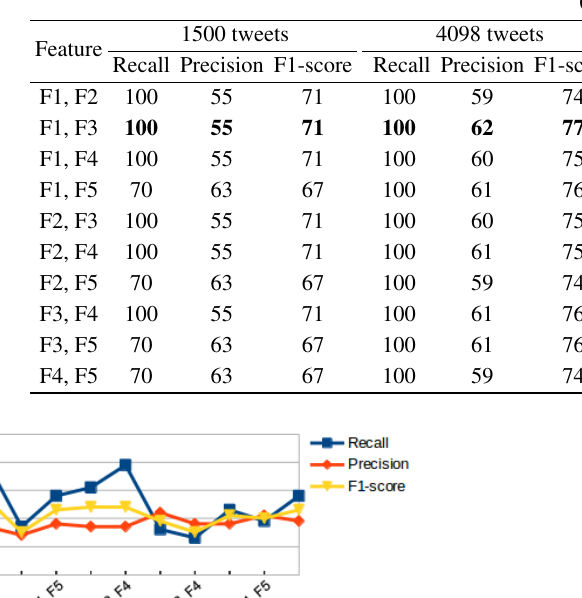
Fig. 4 Comparison of SVM classifier with different kernels. Table 7 Comparison of two different combinations of features in linear kernel.